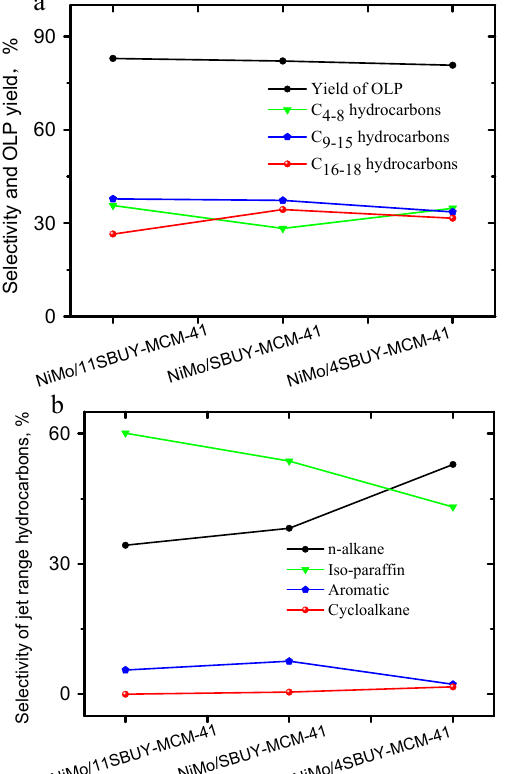
Figure 9. Product selectivity in the hydrotreatment of WCO over NiMo/SBUY-MCM-41. ( a ) Hydrocarbon distribution and ( b ) hydrocarbon composition.